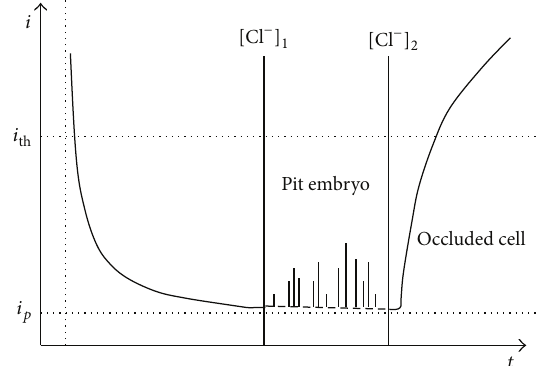
Figure 10: Effect of time and chloride concentration on pitting initiation.